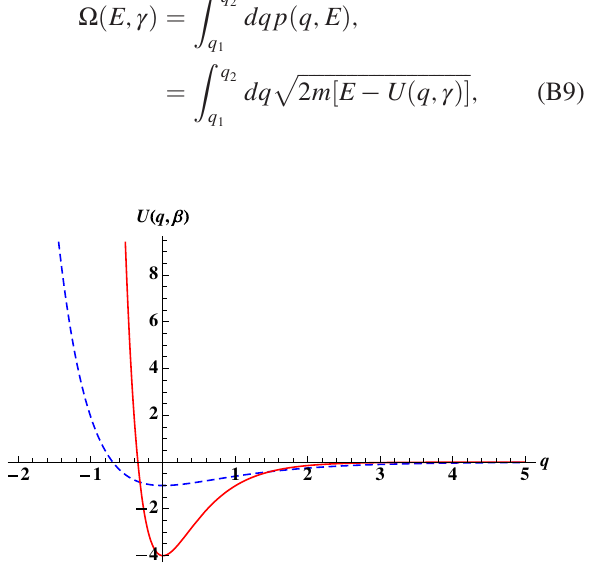
FIG. 4. Scale-invariant counterdiabatic driving of the Morse oscillator. Morse potential U ð q; β Þ [Eq. (B7)] for γ ¼ 1 (dashed blue line) and γ ¼ 1 = 2 (solid red line).